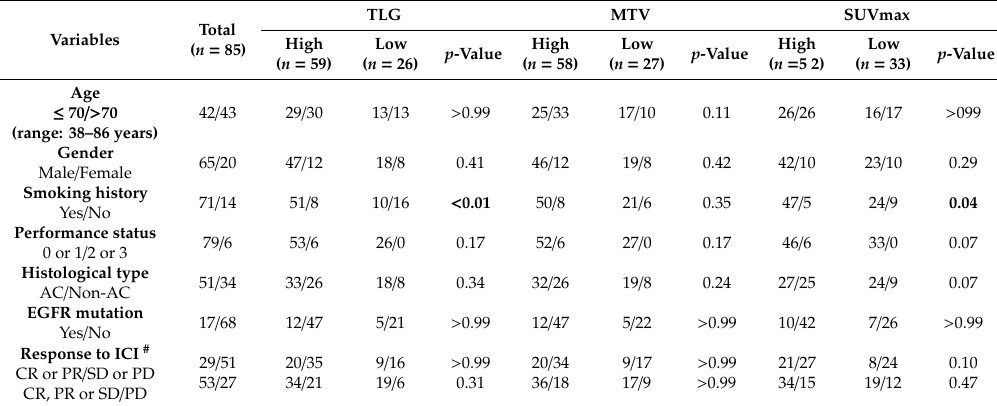
Table 1. Patient’s demographics according to the assessment of FDG